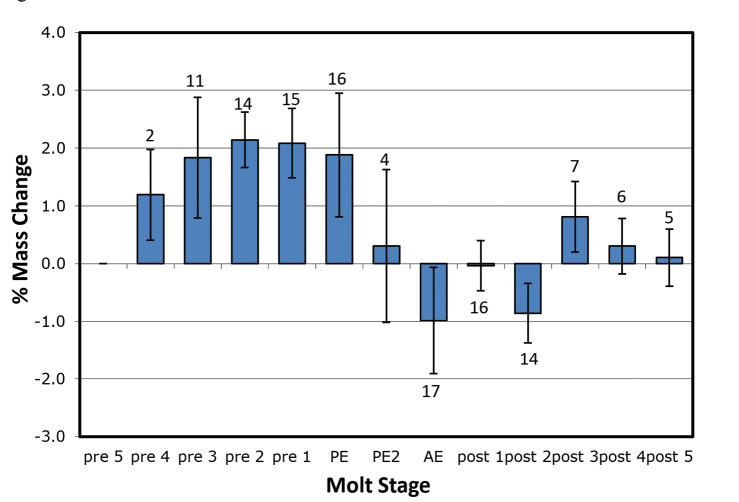
Mass changes of Armadillidiumvulgare during molting in 97 % RH, without access to food. Details as in Figure 1. PE2 refers to the small number of animals reaching a second day after PE without completing the anterior ecdysis.